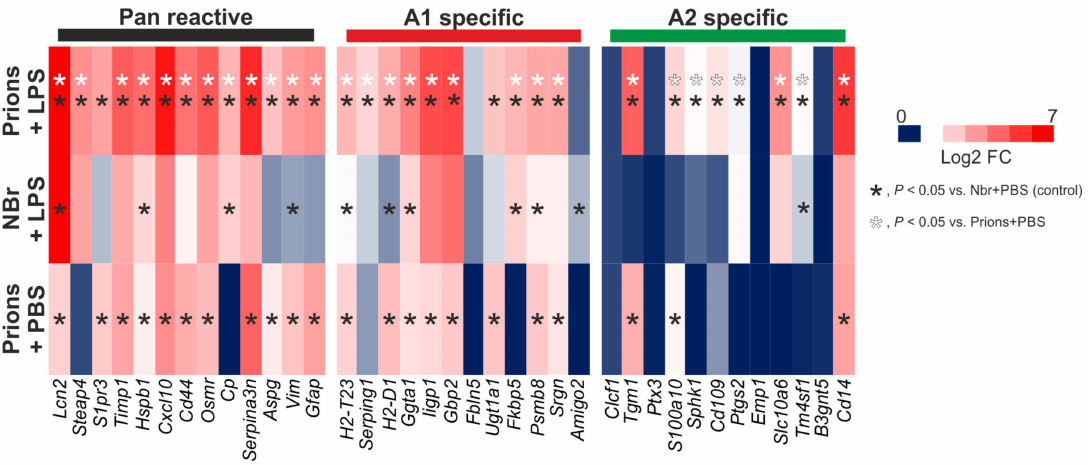
Figure 7. Systemic LPS treatment elevates the expression of pan-, A1 neurotoxic- and A2 neuroprotective reactive astrocyte-associated genes in the hippocampus of mice infected with ME7 scrapie prions. Analysis of a published microarray dataset (NCBI GEO accession no: GSE23182; [184]) of the e ff ects of LPS treatment on astrocyte-associated gene expression in the brains of mice infected with prions. Mice were systemically injected (IP) with at 18 weeks post-IC injection with prions. Hippocampi were removed 6 h later and gene expression compared by microarray. Parallel sets of mice were injected with PBS or normal brain homogenate (NBr) as controls. Heatmap shows log2 fold change when compared to uninfected control mice injected with PBS. n = 3 mice /